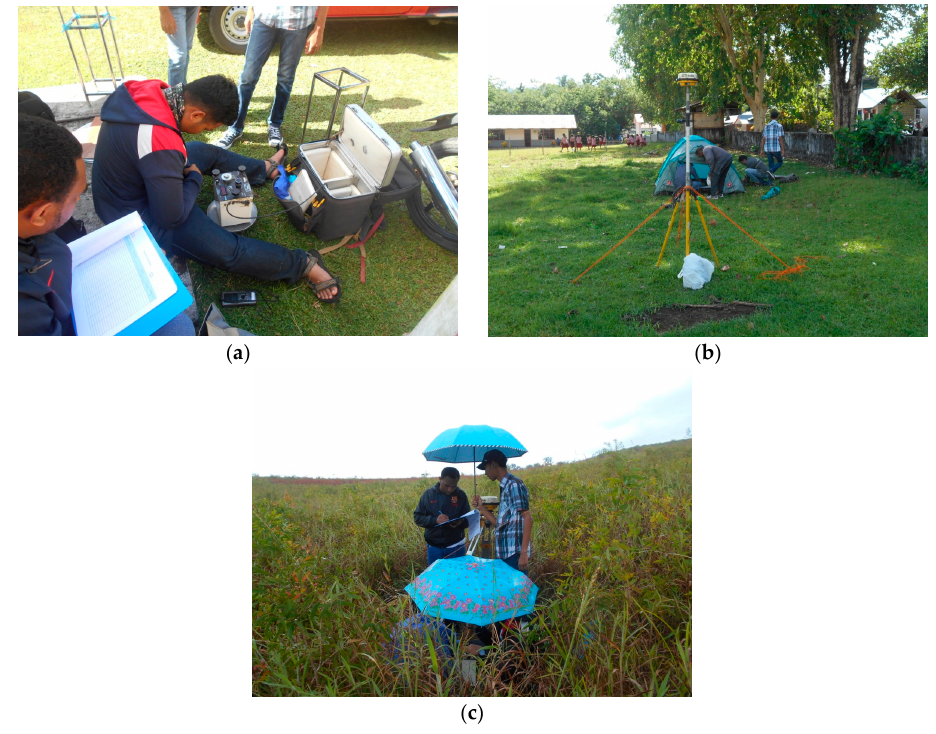
Figure 3. Gravity field and GPS measurements in Suli and Tulehu, ( a ) gravity base station at Suli village; ( b ) GPS base station at Suli village; ( c ) the gravity field and GPS measurement in one of the stations.